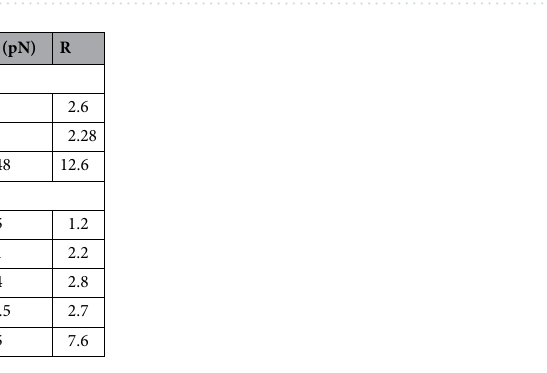
Figure 5. The design and acoustophoretic simulation of the hybrid aluminum-PDMS microchannel. ( a ) Hybrid aluminum-PDMS microchannel, ( b ) one-displacement actuation representing the one piezoelectric system, ( c ) two-displacement actuation representing the two piezoelectric system, ( d ) semi-log plot of acoustic energy density of the fluid domain (blue curve) and the solid domain (red curve) of the two-displacement actuation, ( e ) is the same as ( d ) but for one-displacement actuation, ( f ) average acoustic radiation force in the z direction (blue curve) and in the y direction (red curve) under the two-displacement actuation, ( g ) is the same as ( f ) but for one-displacement actuation.